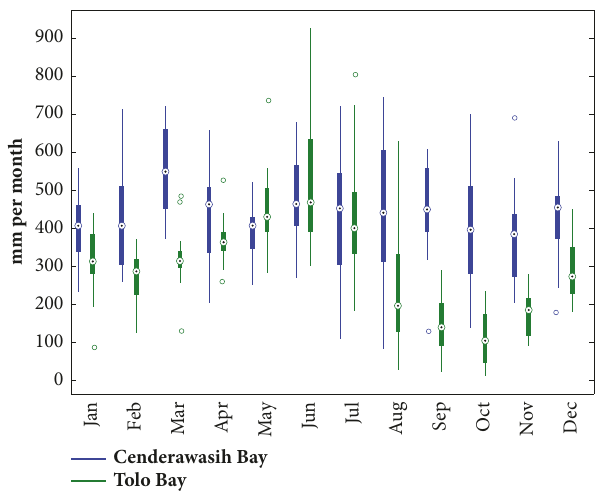
Figure 3: Box and whisker plot for monthly offshore rainfall variabilityoverCenderawasihBay(blue)andToloBay(red).Thetop and bottom of the large box denote the 25th and 75th percentiles. The circle in the box denotes the 50th percentile or median of the distribution. The bars extend to the largest or smallest value within 1.5 times the interquartile range of the 75th or 25th percentiles, respectively. The interquartile range is defined as the distance between the 25th and 75th percentile values. The whiskers are outliers.